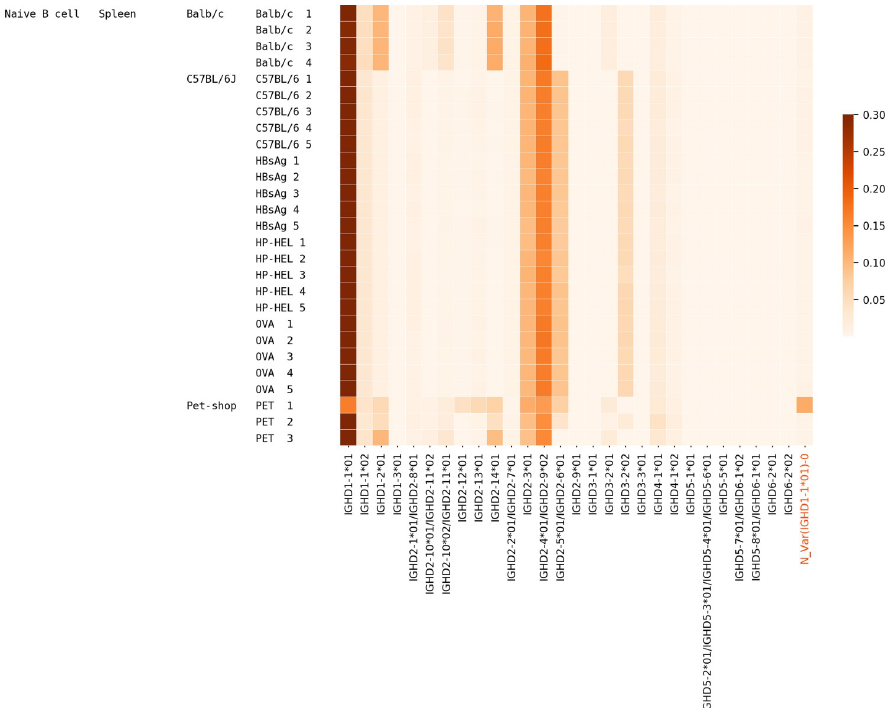
Fig 14. Usage of various known and novel genes/variations in MICE datasets. Columns on the left represent cell type, tissue, strain, and individual respectively. OVA, HP-HEL, and HBsAg in the right most column represent the C57BL/6J mice immunized with OVA, HP-HEL, and HBsAg, respectively. For example, OVA 3 represents the C57BL/ 6J mouse number 3 that was immunized with OVA.